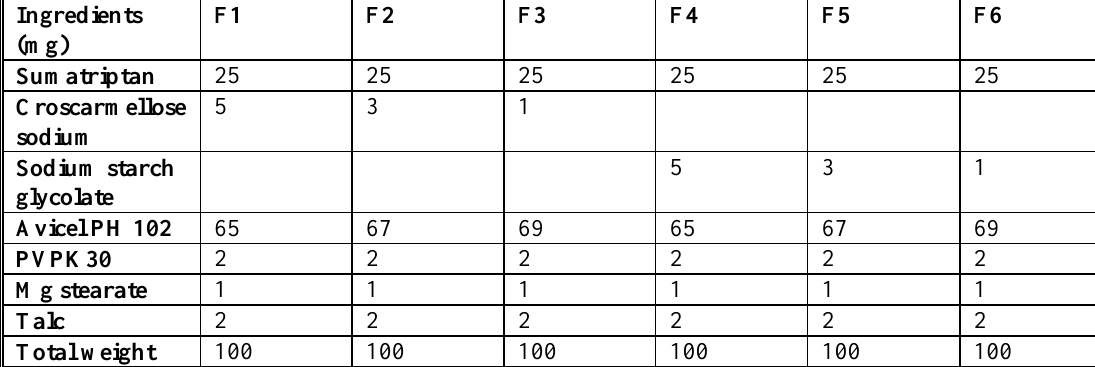
Table 1. Composition of core powder